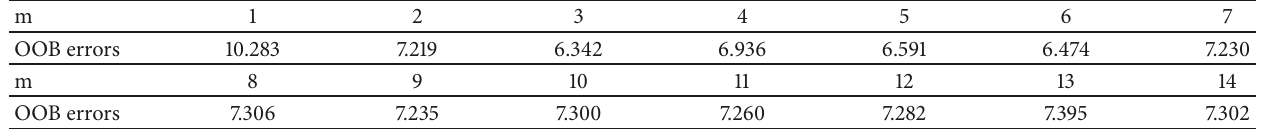
Table 5: The OOB errors with a different number of independent variables in each split.